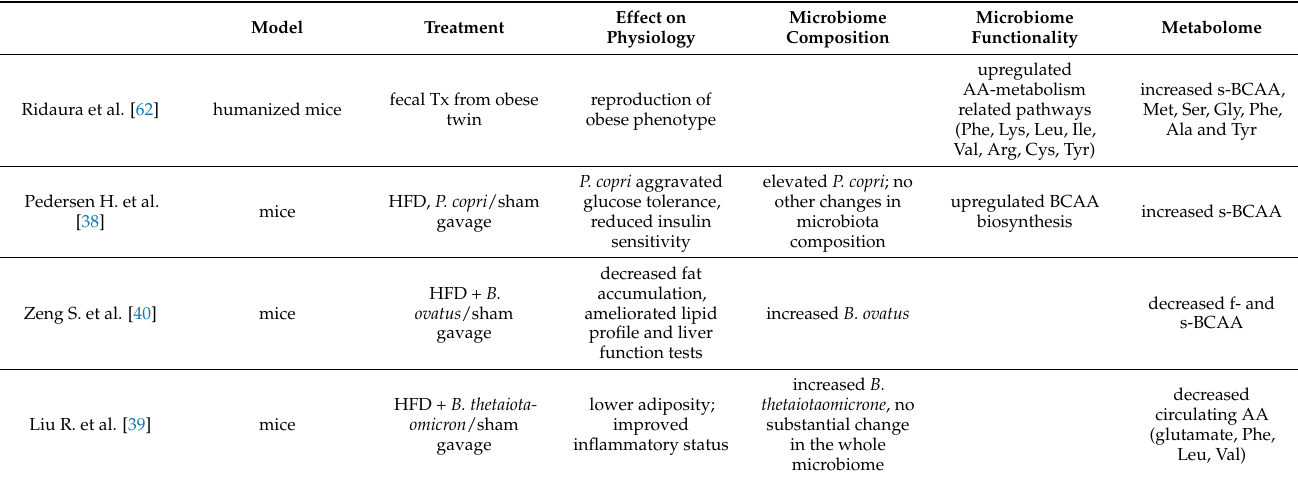
Table 3. The effect of specific bacterial taxa on BCAAs concentration in